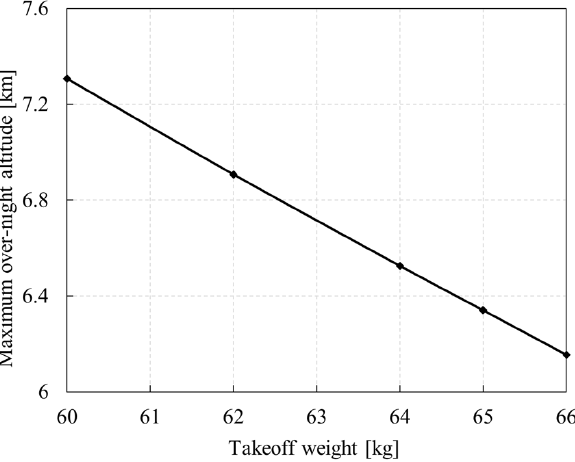
Figure 33. Influence of takeoff weight on maximum overnight altitude (Mar. 21, 41° N).